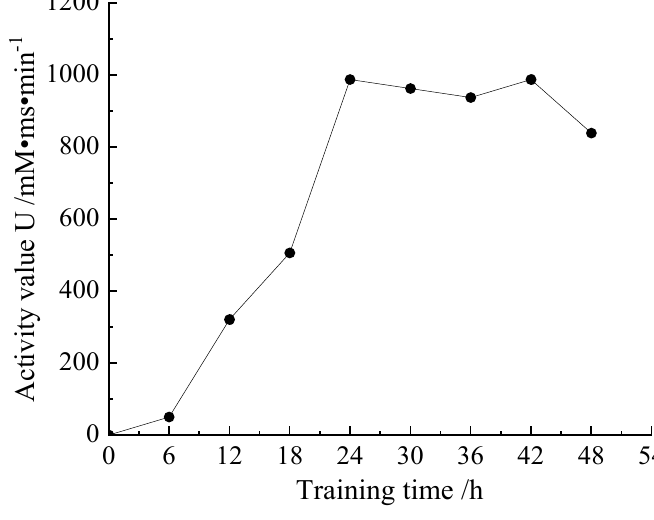
Figure 1. Urease activity curve.